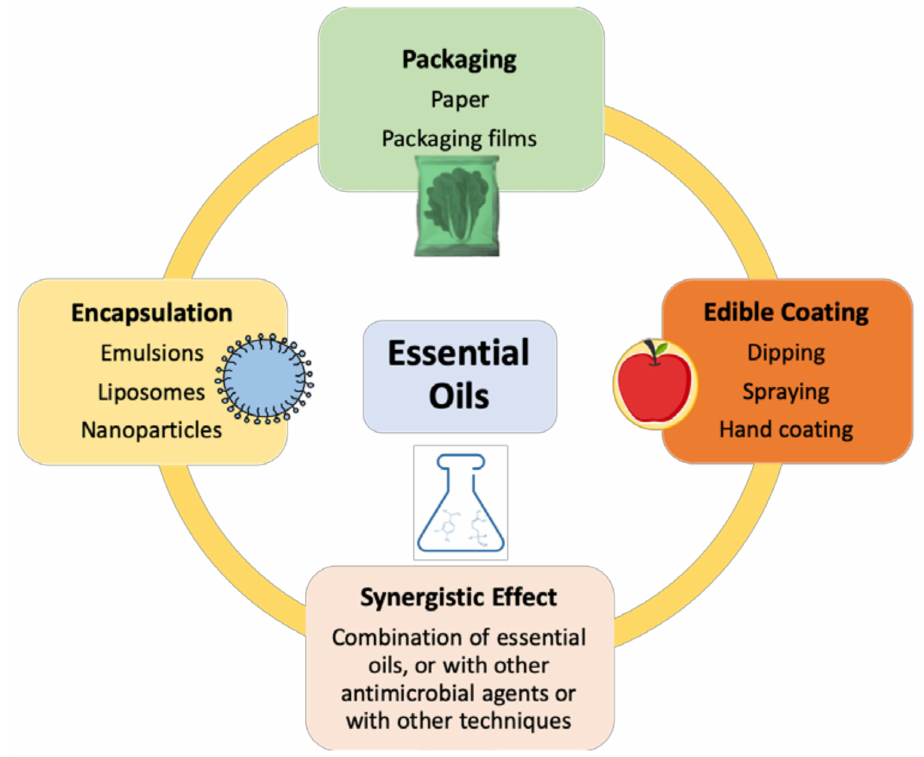
Figure 3. Innovative applications of EOs in MP